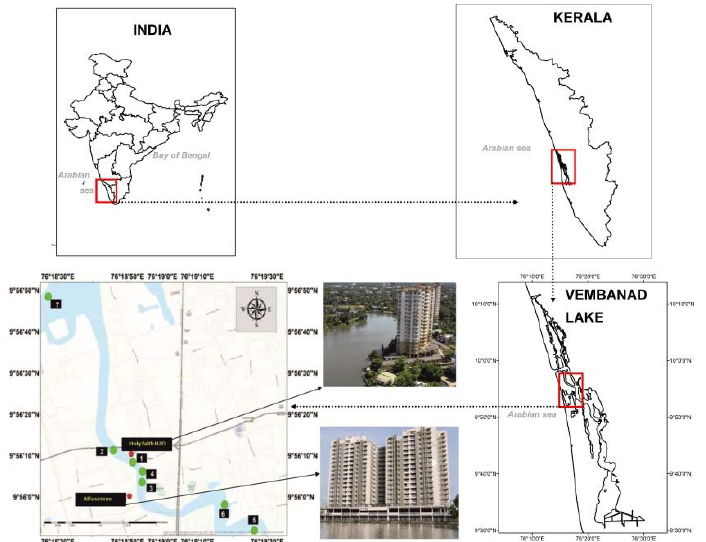
Figure 1. Location map of the demolition sites and sampling sites. Inset images show the two buildings before demolition (image courtesy: dailyhunt.in). The location of Vembanad Lake in the southwestern state of Kerala and in India is also shown as insets.